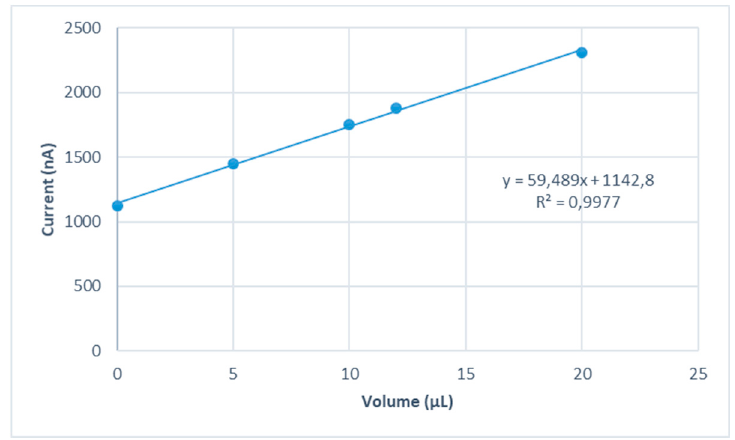
Figure 1. An example of calibration curve using the addition standard method.